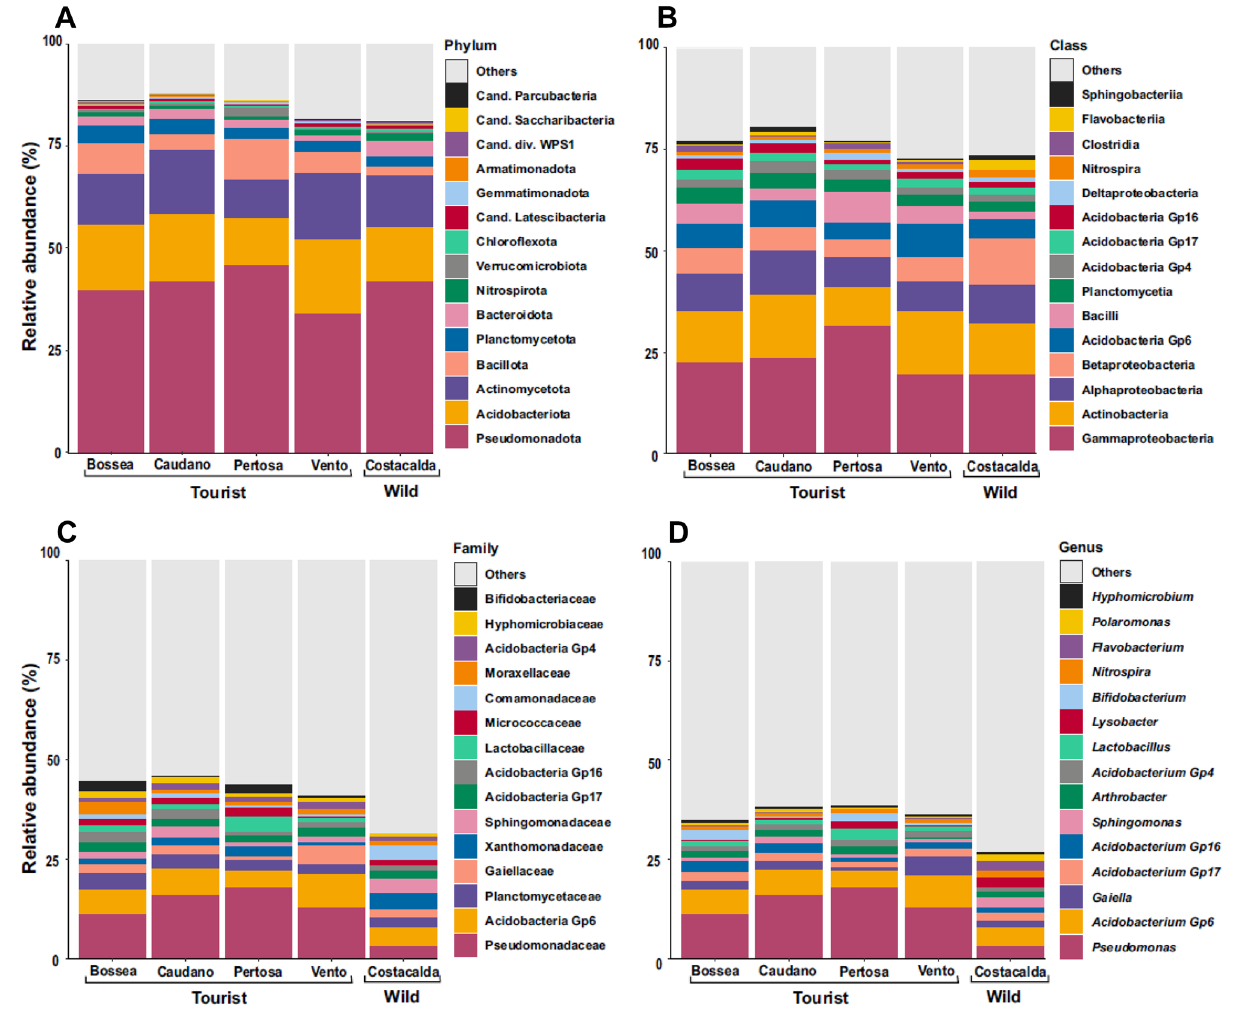
Figure 3. Bacterial community composition of 5 caves studied: Bossea, Caudano Pertosa-Auletta, Vento (show- caves) and Costacalda (wild cave). The top 15 most abundant taxa are shown for taxonomic ranks: phylum ( A ), class ( B ), family ( C ) and genus ( D